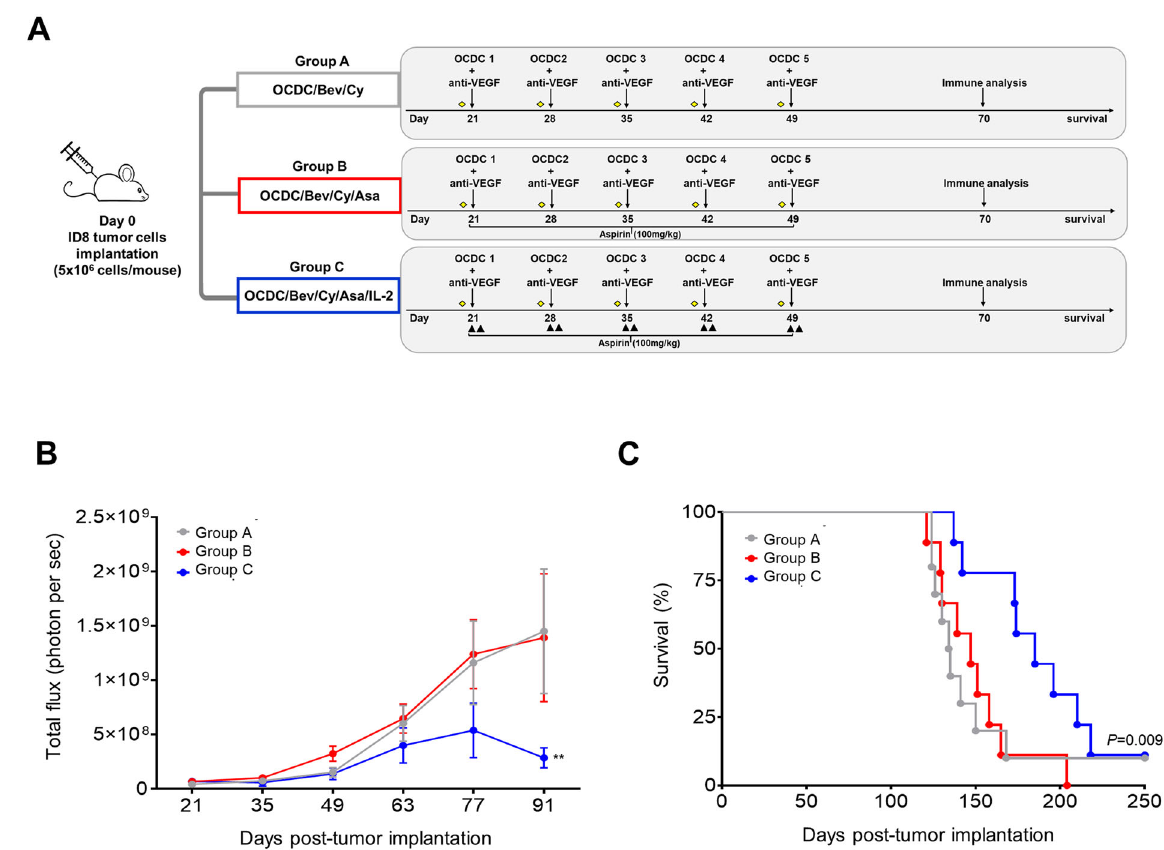
animal) and randomized into Group A, B, or C. All animals received Cy (40 mg/kg, indicated as diamonds, given i.p.) before each OCDC, and anti-VEGF blocking antibody (2 mg/kg, clone B20-4.1.1, mouse IgG2a, given intraperitoneally [i.p.]) together with each OCDC. Group B and C received ASA via drinking water (100 mg/kg). Group C also received recombinant mouse low-dose IL-2 (15 µg/kg, given i.p.) on 2 consecutive days following OCDC vaccination. Five weekly OCDCs were given intradermally in the groin region (1 × 10 6 DCs/50 µl sterile PBS/animal). B Quanti fi cation of tumor burden with bioluminescence imaging. Results were reported as total fl ux (photons per second). The tumor burden of Group C was signi fi cantly lower when compared to Group A ( P = 0.008) and B ( P = 0.004). One-way ANOVA and Tukey ’ s multiple comparisons test for signi fi cance were performed. C Comparison of the survival curves of animals receiving different regimens ( P = 0.009; Log- rank Mantel – Cox test). Group C showed the longest median OS of 185 days. In all the analyses, P < 0.05 was considered signi fi cant. The data were representative of three separate experiments. Total n = 9 animals per